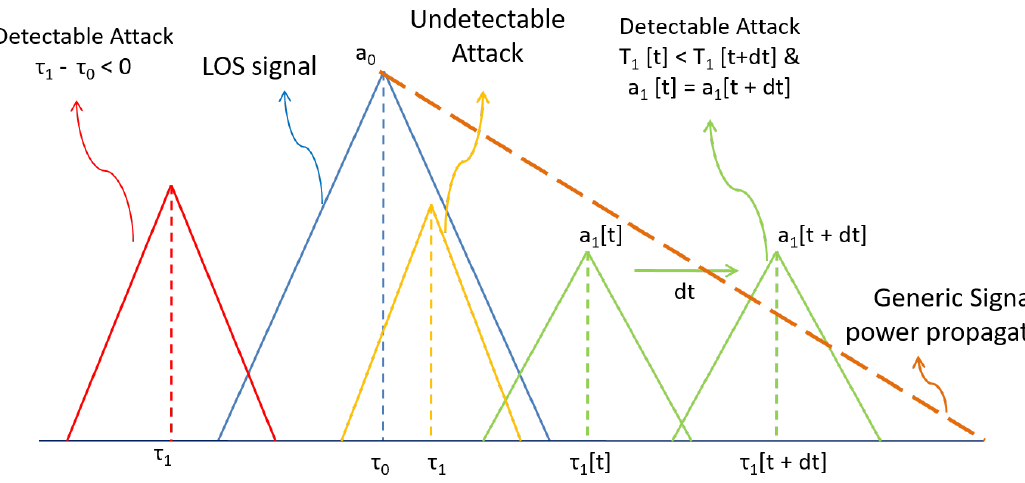
Figure 6. Impairment distinction based on soft observations. The signal in red is detected as a spoofing attack because the delay difference τ 1 − τ 0 is negative. The green one is detected because the delay increases, but the amplitude is maintained constant, and the yellow one is classified as impairment because there is not enough information to allow